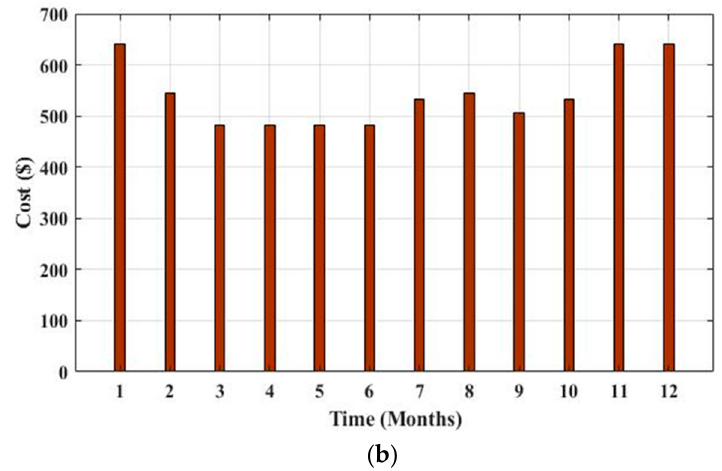
Figure 8. ( a ) EC and ( b ) energy cost of set point switching devices.